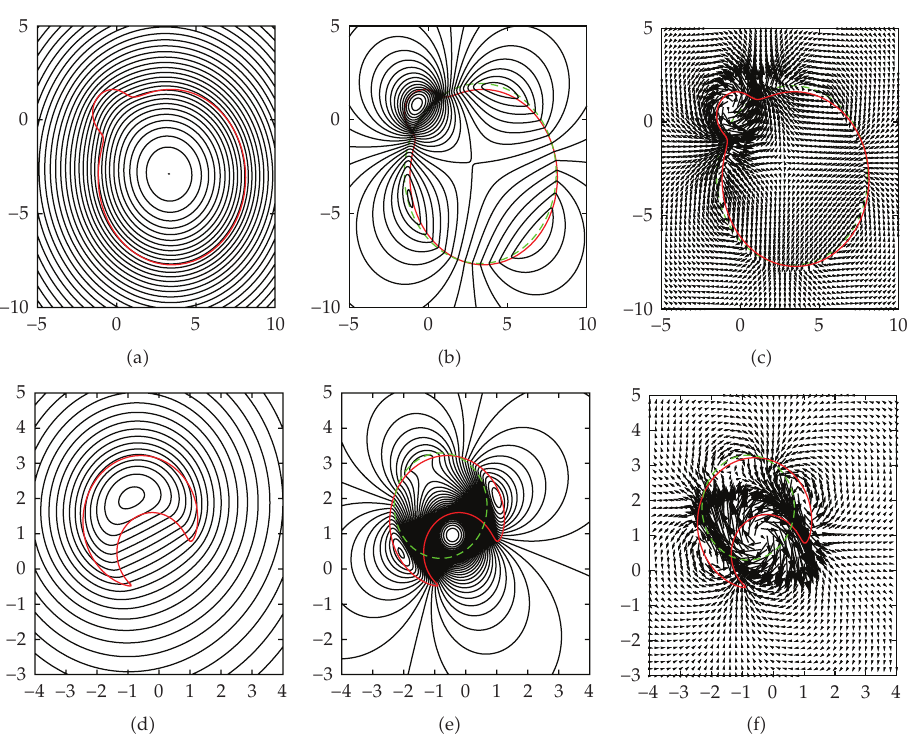
Figure 8: As in Figure 7, but for the vortices of Figures 4 (cid:2) c (cid:3) and 4 (cid:2) f (cid:3) . The steps between two streamlines are (cid:2) a (cid:3) 0 . 5, (cid:2) c (cid:3) 0 . 1, and (cid:2) b (cid:3) , (cid:2) d (cid:3) 0 . 04, while the scale factor in drawing the di ff erential velocities (cid:22) u is